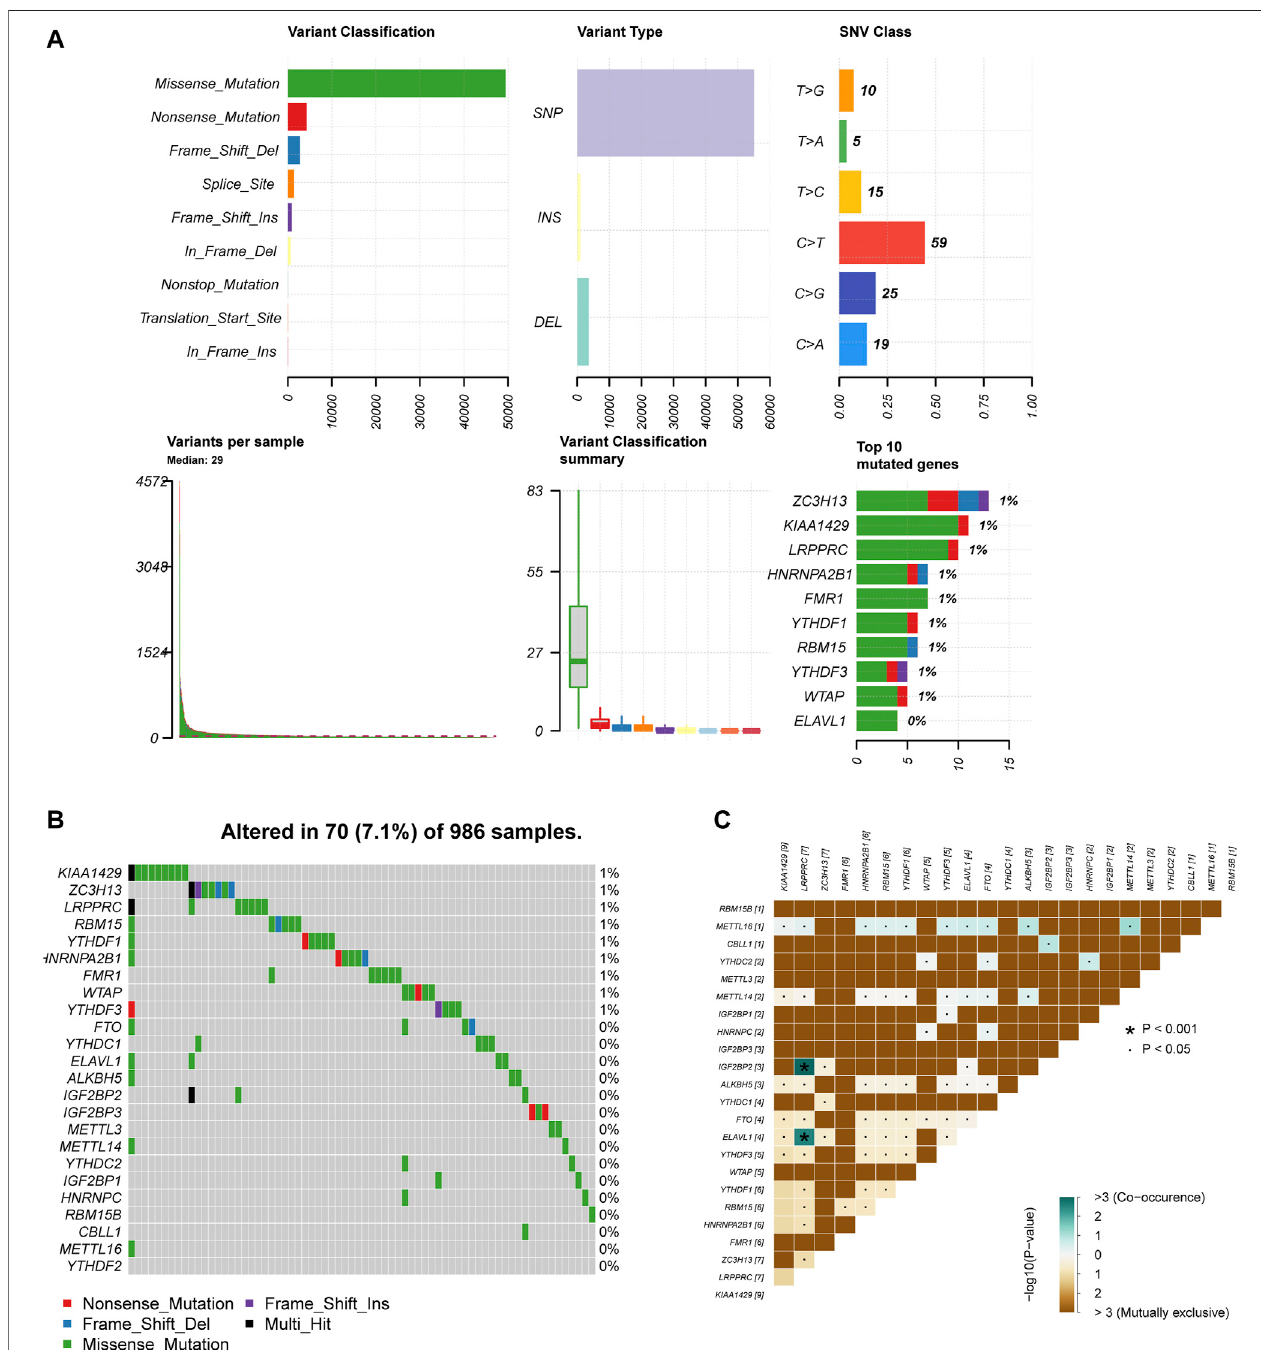
FIGURE 4 | M6A regulators present a low genetic variation rate. (A) The summary of 24 m6A regulators copy number variation and somatic mutations in breast cancer. (B) The mutation frequency of 24 m6A regulators 986 samples. (C) Co-mutation among 24 m6A regulators.